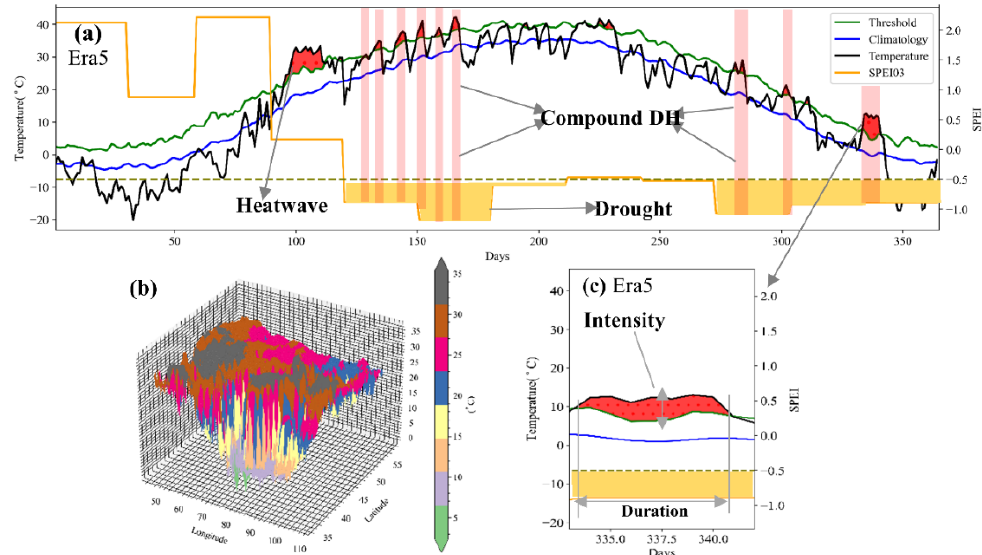
Figure 2. Coupling mechanism diagram of drought events, heatwave events, and CDHWs. ( a ) Drought events, heatwave events, and CDHWs that are defined by randomly selected grid points at certain locations in a certain year; specific times and locations are shown at the thresholds of 9°E, 11.5°N, and at 18 grid points in 2012. ( b ) Three-dimensional spatial distribution of heatwave thresholds ( c ) showing the local magnified details of ( a ). The intensity and duration of CDHWs are further indicated.